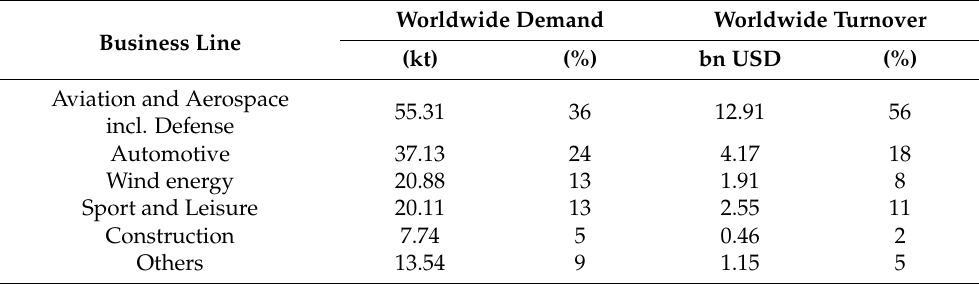
Table 4. The use of composites reinforced with carbon fibers by application in 2018